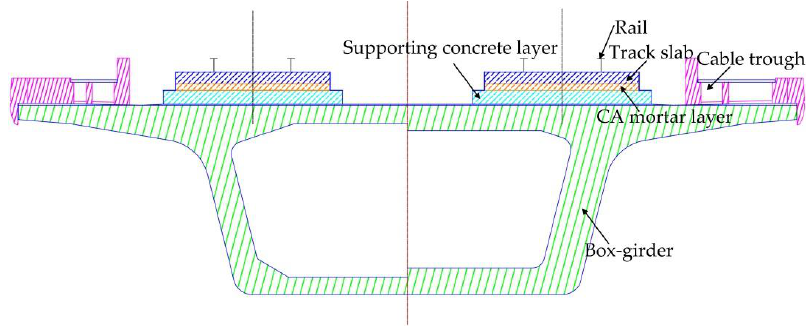
Figure 1. Cross-section sketch of CRTS-II-slab ballastless track structure on the viaduct.